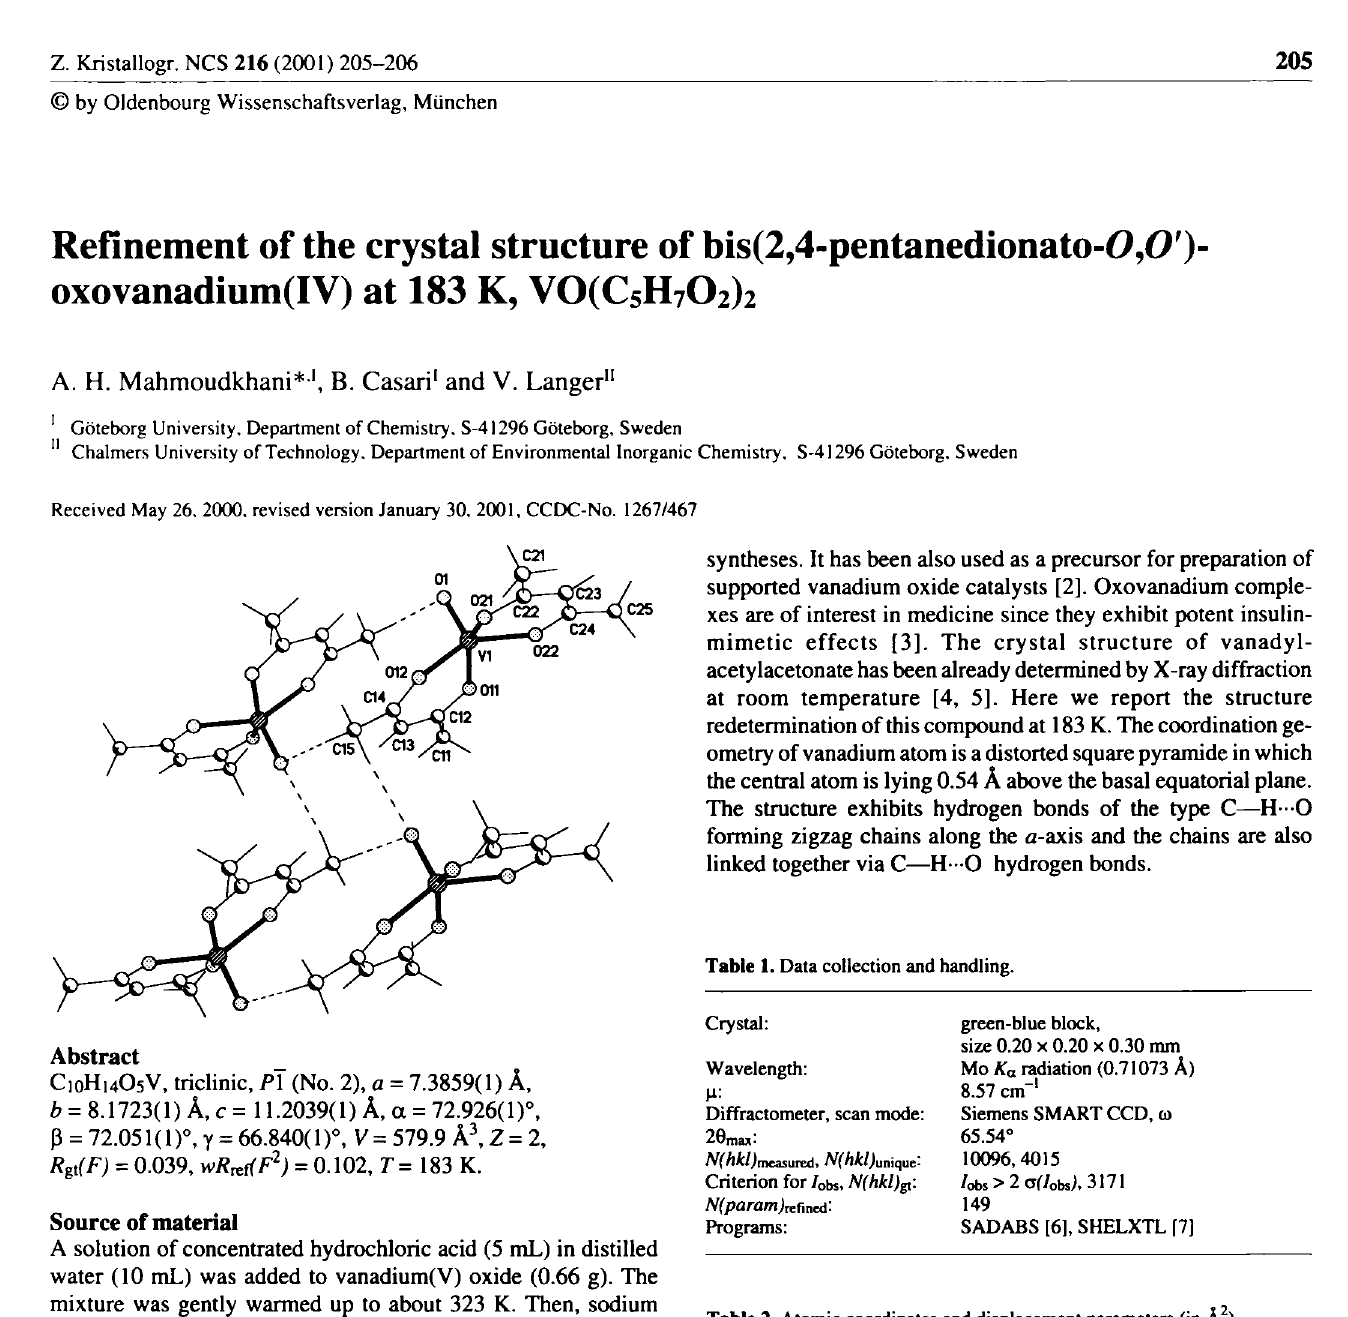
Table 2. Atomic coordinates and displacement parameters (in A 2